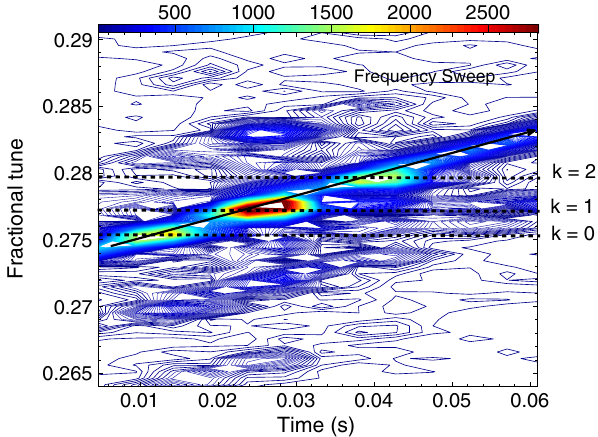
FIG. 19. Vertical tune spectra with frequency sweep over time at N 7 þ with 1 : 5 (cid:7) 10 9 particles. The various modes get indi- vidually excited as the sweep frequency (marked by the arrow) coincides with the mode frequency. The k ¼ 0 ; 1 ; 2 modes are marked. Symmetric sidebands due to coherent synchrotron os- cillations are visible around the sweep frequency spaced with Q s and are clearly distinguished from the head-tail modes.